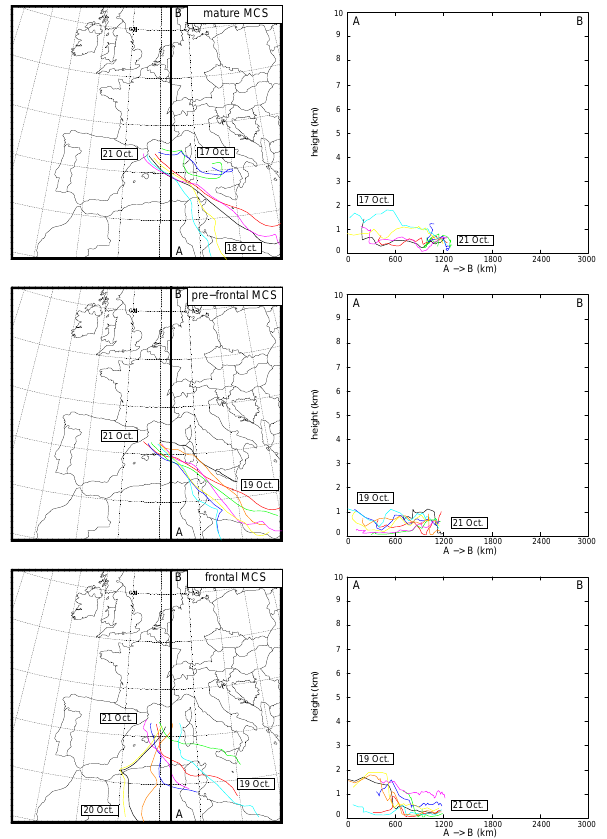
Fig. 19. Same as Figure 18 for the feeding of three different phases of the 21 Oct. 2008 event - mature convection well ahead of the front (top),pre-frontalconvection (middle)andconvection embeddedinafrontaldisturbance(bottom).